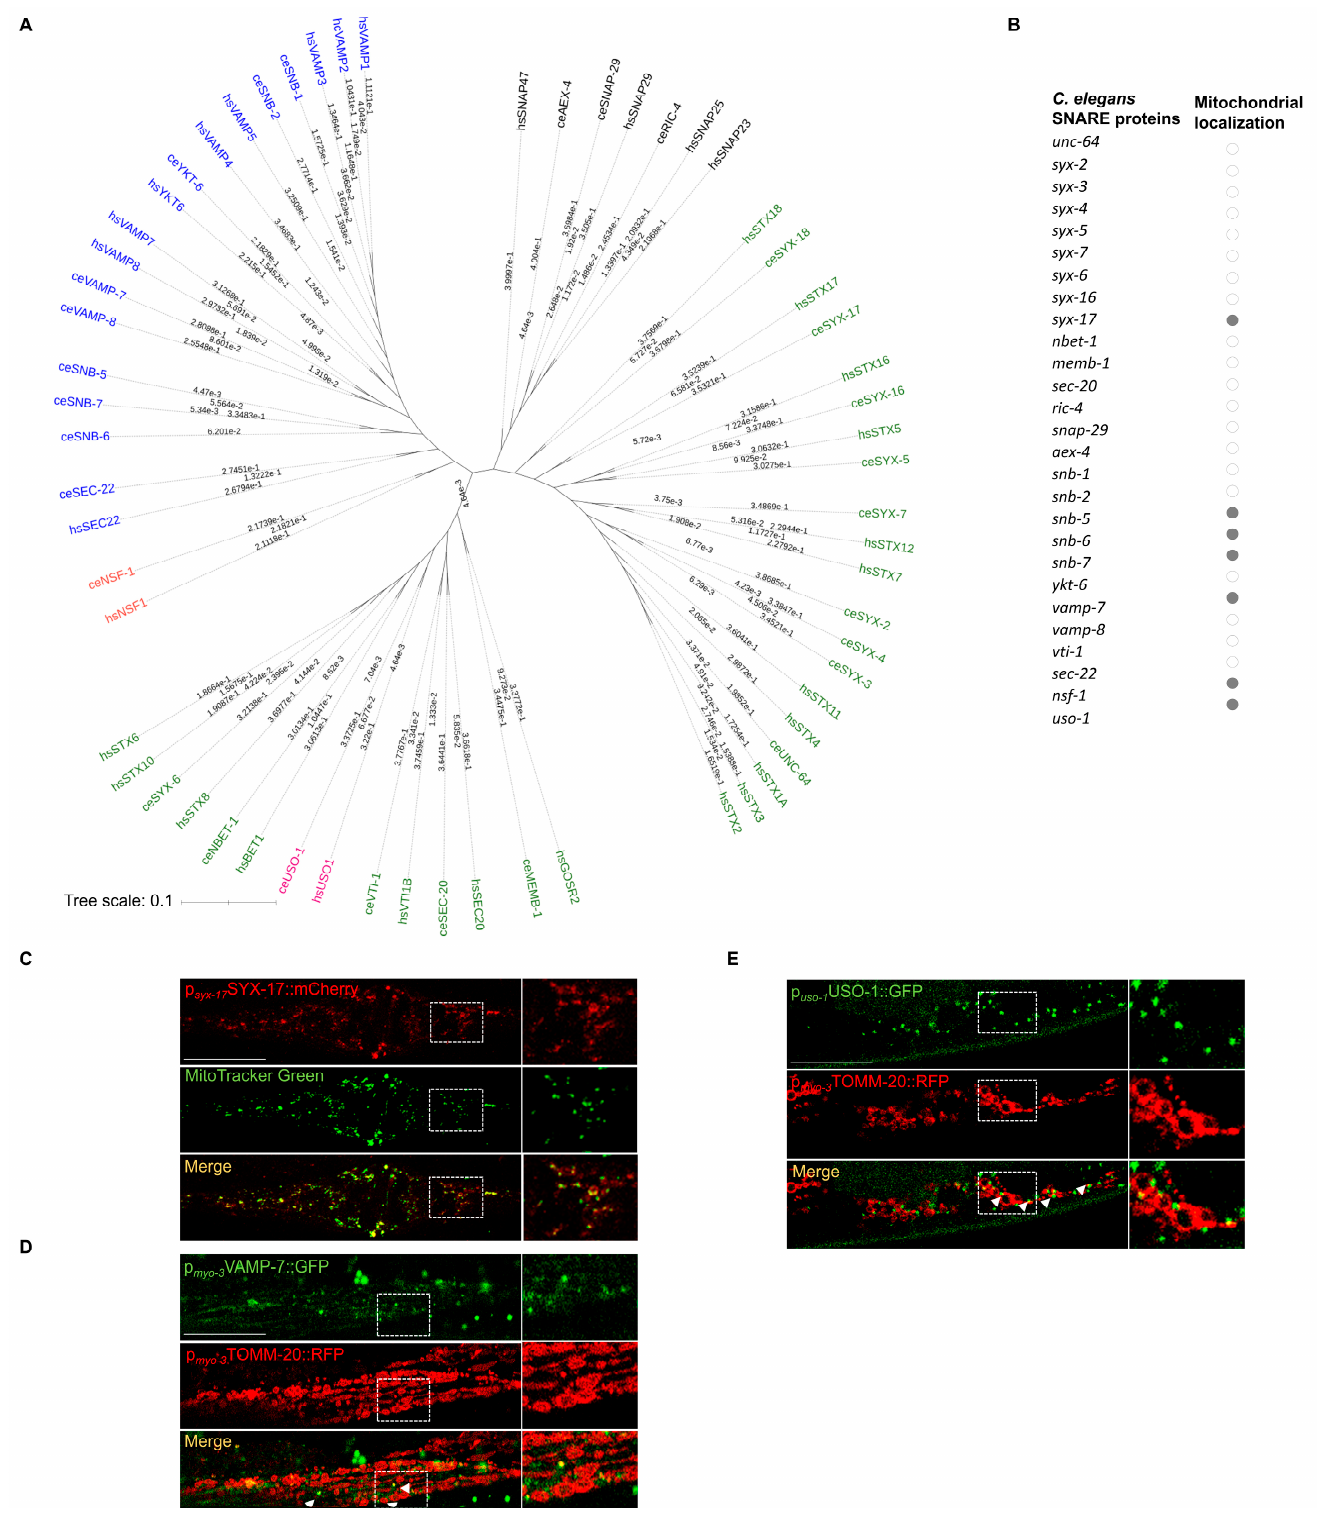
Figure 1. Members of the SNARE protein family are localized to mitochondria. ( A ) Phylogenetic tree of most SNARE and SNARE-coupling proteins between C. elegans and humans showing the evolutionary relatedness (v-SNAREs/synaptobrevis/VAMPs are colored blue, t-SNAREs/syntaxins green, tethering factor USO-1 pink, disassembly factor NSF-1 orange). ( B ) List of most SNARE and SNARE-coupling proteins in C. elegans that were predicted to be exported to mitochondria (dots marked in grey). ( C ) Transgenic animals expressing syx-17 fused with mCherry under the control of its own promoter were stained with MitoTracker Green demonstrating that SYX-17 is present in